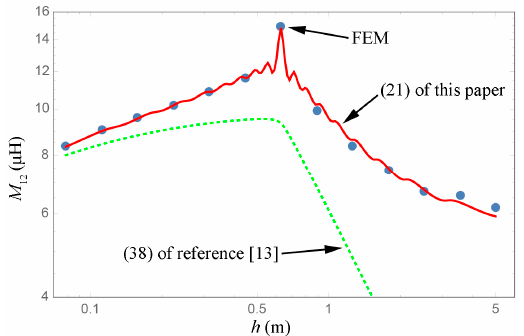
Figure 12. Pitch length ( h ) dependence of the mutual inductance ( M 12 ) of coils with different heights.